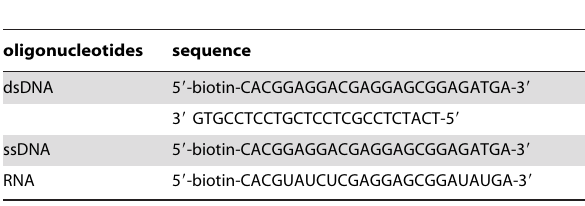
Table 3. Oligonucleotides used in SPR